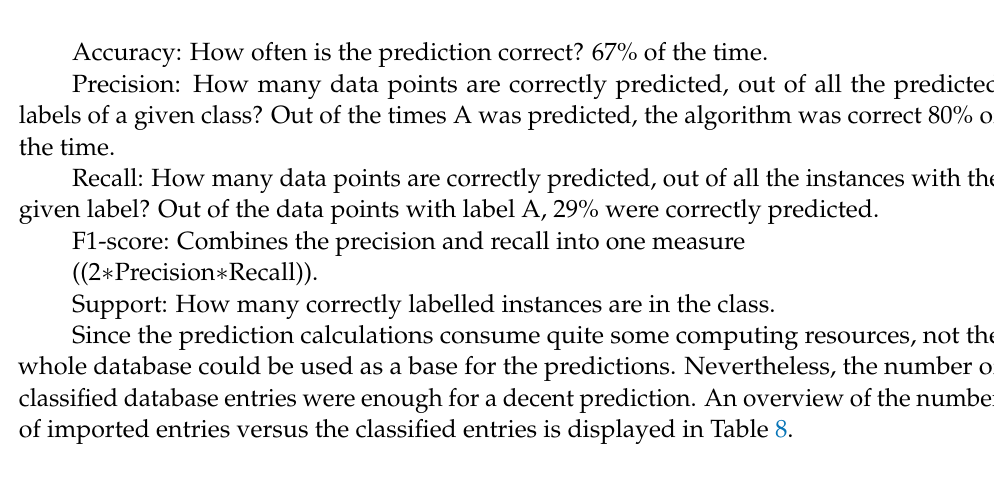
Table 7. Confusion matrix for England.